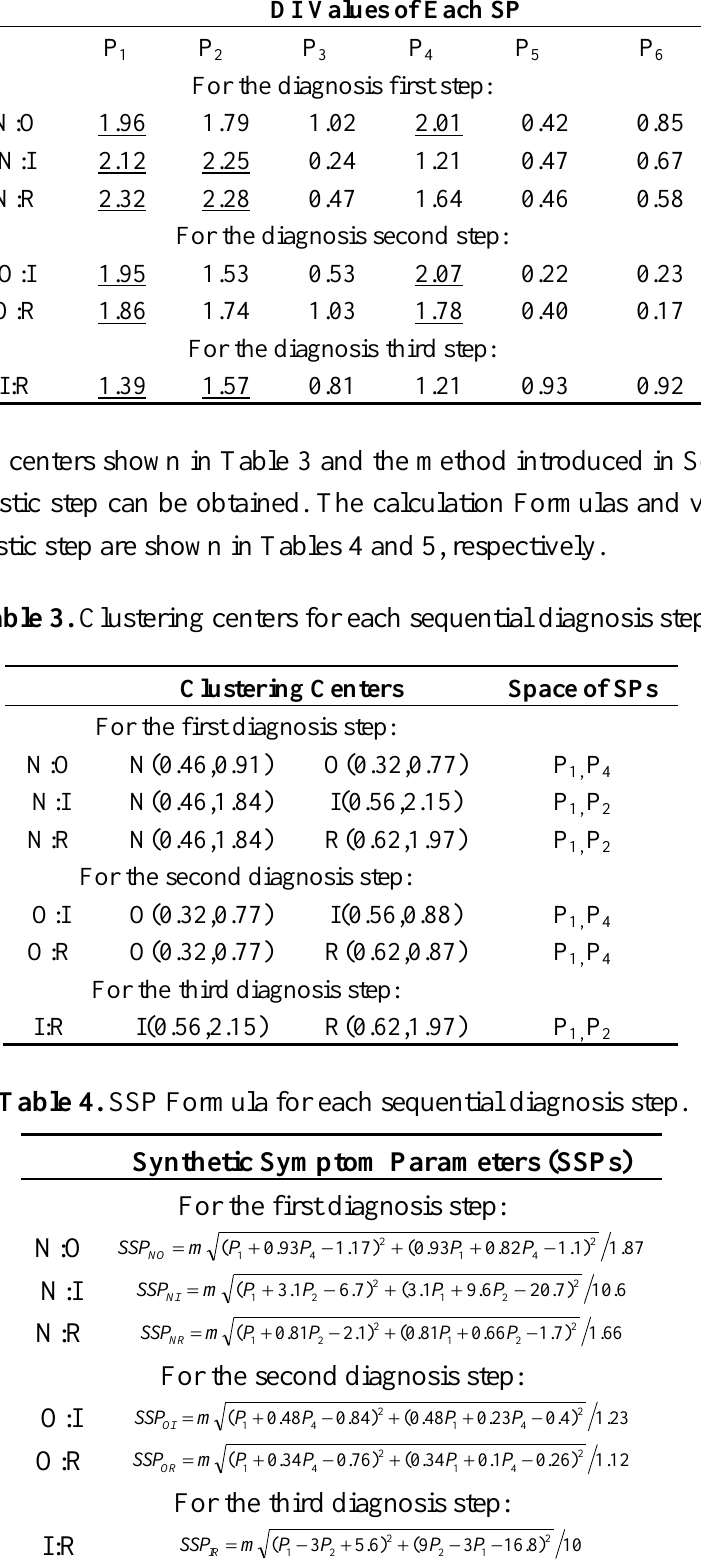
Table 2. DI values of the SPs for each sequential diagnosis step. DI Values of Each SP